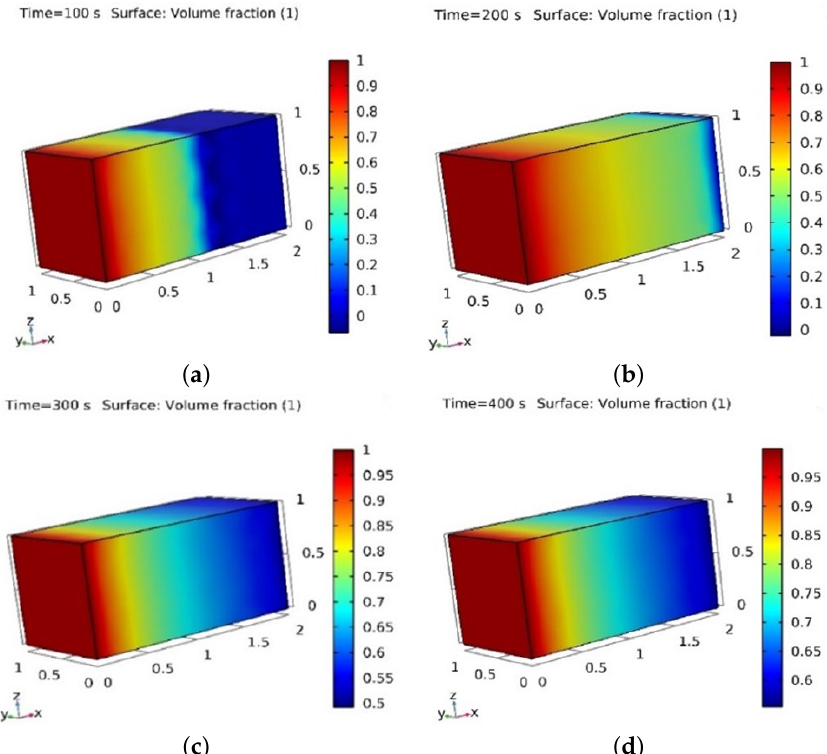
Figure 9. ( a ) Saturation of NF at 100 s, ( b ) 200 s, ( c ) 300 s, and ( d ) 400